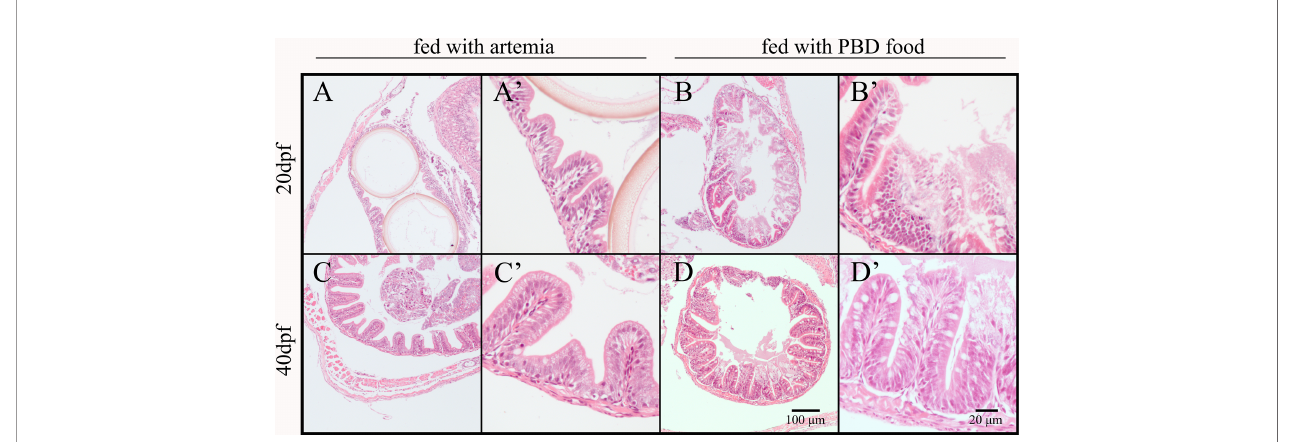
FIGURE 6 | Intestinal morphology of Nile tilapia fed different diets (mid-intestine). (A) 20 dpf fi sh fed Artemia (10×); (A ’ ) 20 dpf fi sh fed Artemia (40×); (B) 20 dpf fi sh fed PBD food (10×); (B ’ ) 20 dpf fi sh fed PBD food (40×); (C) 40 dpf fi sh fed Artemia (10×); (C ’ ) 40 dpf fi sh fed Artemia (40×); (D) 40 dpf fi sh fed PBD food (10×); (D ’ ) 40 dpf fi sh fed PBD food (40×).